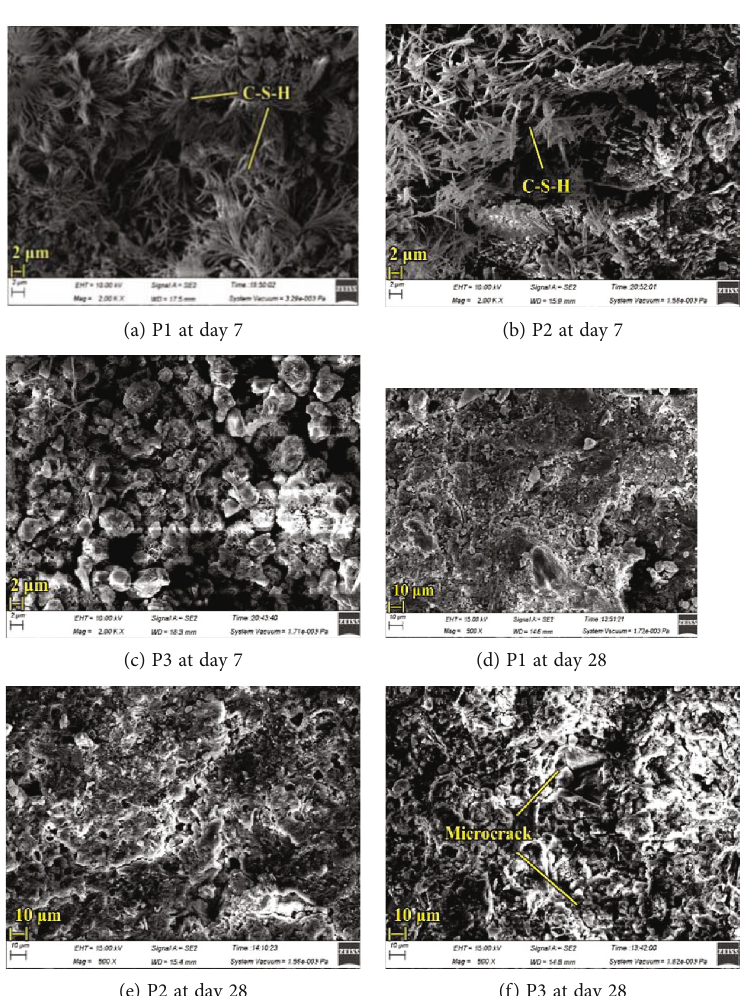
Figure 10: Microstructure of cement